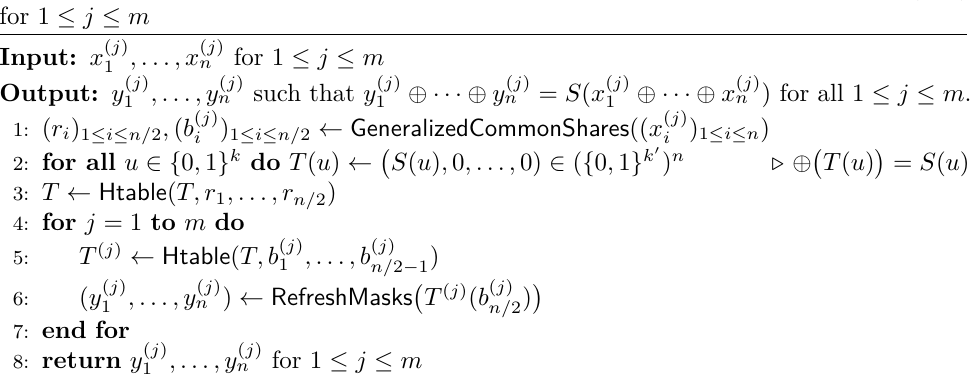
Algorithm 9 Generalized Common Table : common masked computation of y ( j ) = S ( x ( j ) ) for 1 ≤ j ≤